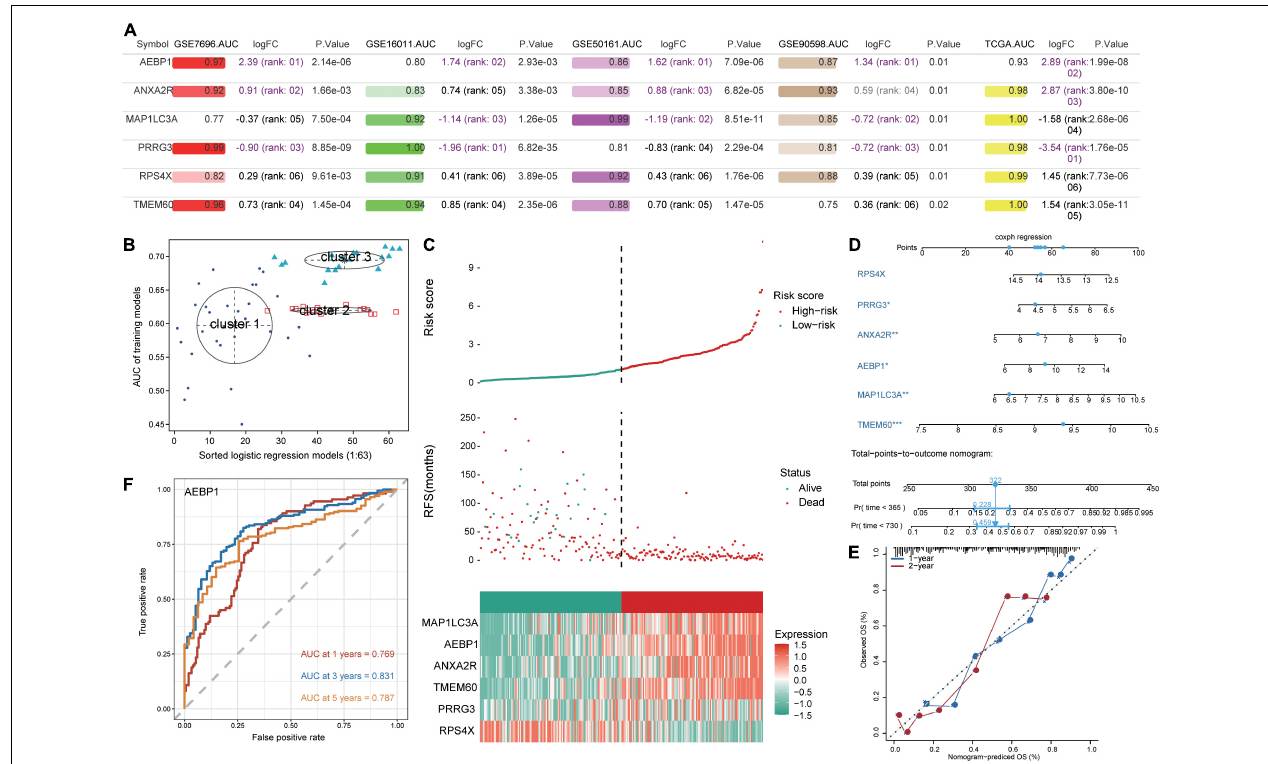
FIGURE 4 | Prediction of GBM patient survival based on candidate genes. (A) Areas under the receiver operating characteristic curve (AUCs), fold change in differential expression, and P value associated with candidate genes based on the datasets GSE16011, GSE7696, GSE50161, GSE90598, and TCGA. (B) Correlation of AUCs with the logistic regression model was identified using a Gaussian mixed model. (C) Distribution of candidate gene-based risk scores, recurrence-free survival (RFS) and gene expression levels in the GSE16011 dataset. (D) A predictive nomogram was constructed based on candidate genes and the GSE16011 dataset. (E) Agreement between nomogram-predicted and observed overall survival (OS) at one and 2 years. (F) Receiver operating characteristic curve for AEBP1 to predict OS at one, three, and 5 years.